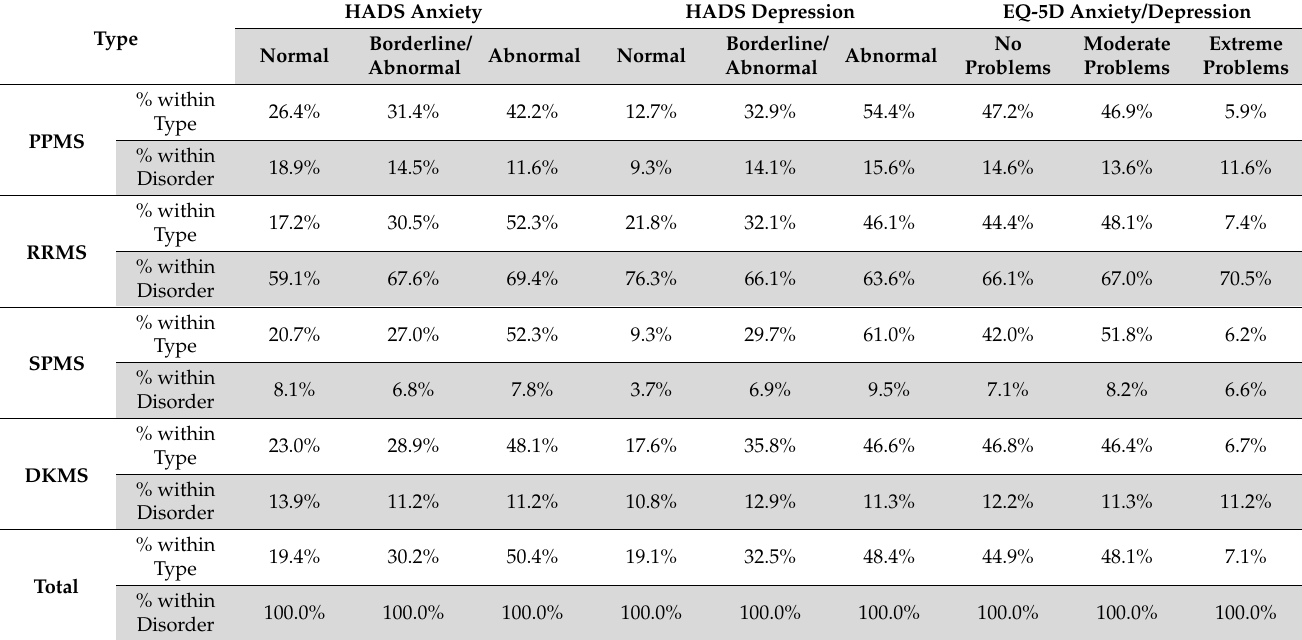
Table 6. Statistics showing anxiety and depression frequencies according to type of MS.